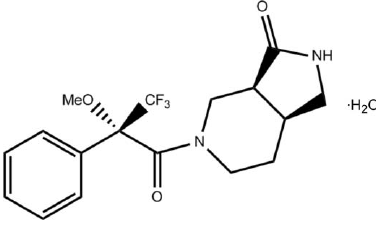
Data collection Bruker APEXII CCD diffractometer Absorption correction: multi-scan ( SADABS ; Bruker, 2001)